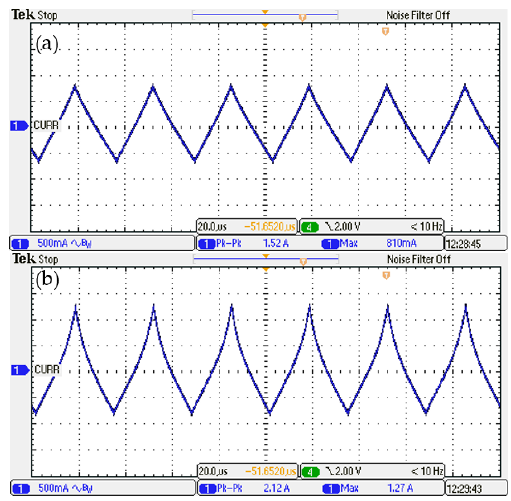
Figure 5. An oscilloscope plot of the current flowing through the power switch shows the influence of T ON on saturation: ( a ) a linear trend is observed for T ON = 15 µs, and ( b ) a non-linear trend for T ON = 17 µs.